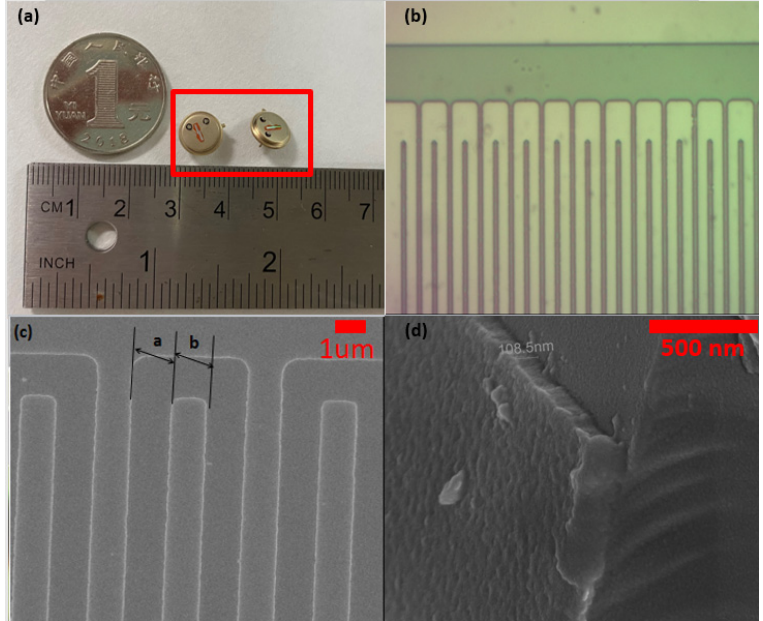
Figure 4. ( a ) One-port SAW resonators, ( b ) Optical microphotograph image of electrodes on bare SAW, ( c ) top view and ( d ) cross-sectional SEM images of interdigital transducers. Figure 5a is the SEM images of graphene/PVDF/CAM/DMMP membrane, showing